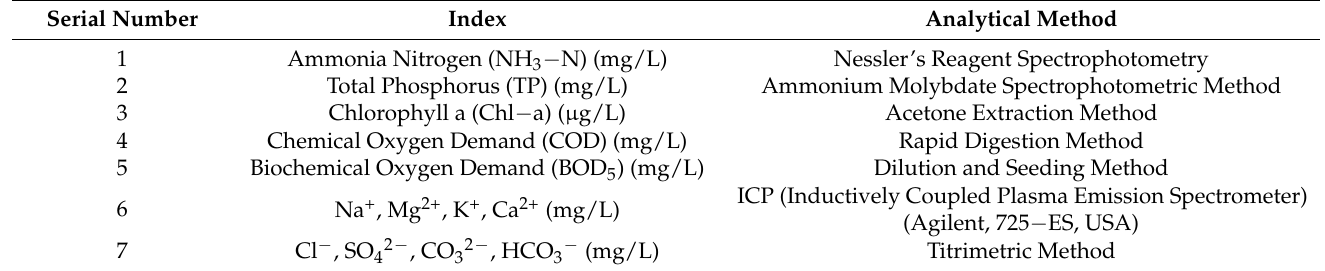
Table 1. Indicators and methods for the detection of Nanhai Lake